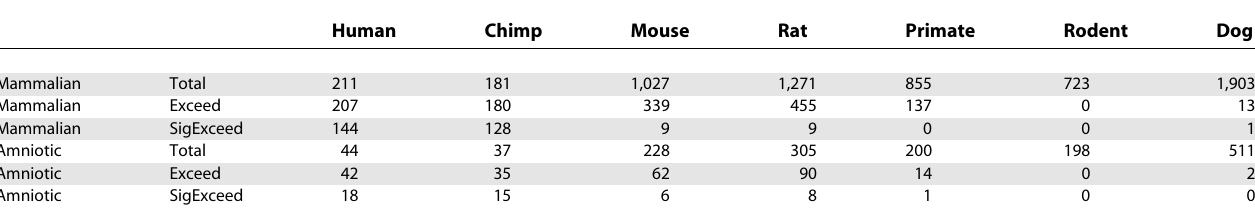
Table 1. Evidence for adaptive evolution in fast-evolving CNCs Human Chimp Mouse Rat Primate Rodent